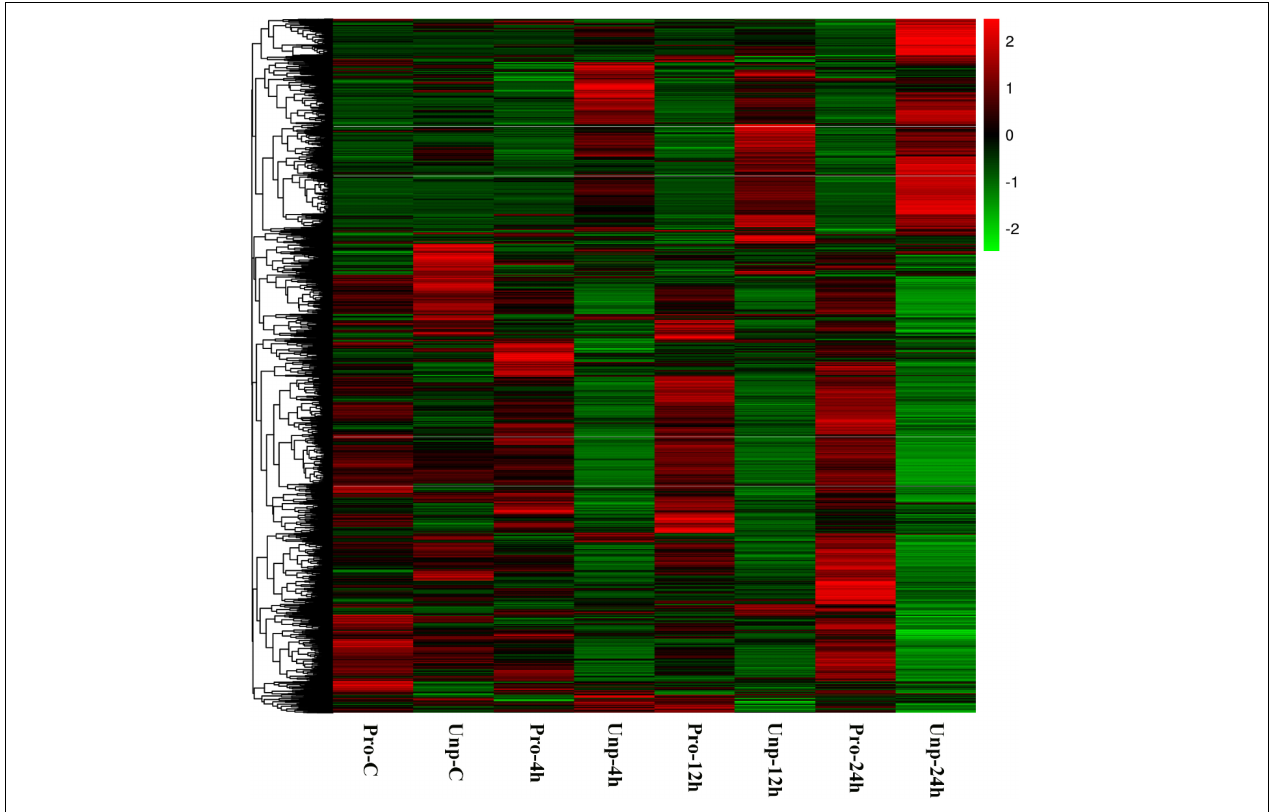
FIGURE 3 | Heatmap analysis of hierarchical clustering of DEGs at four time points in two groups. Each row represents one gene, and each column stands for a time point. The colors range from green to red, indicating the level of expression from low to high.